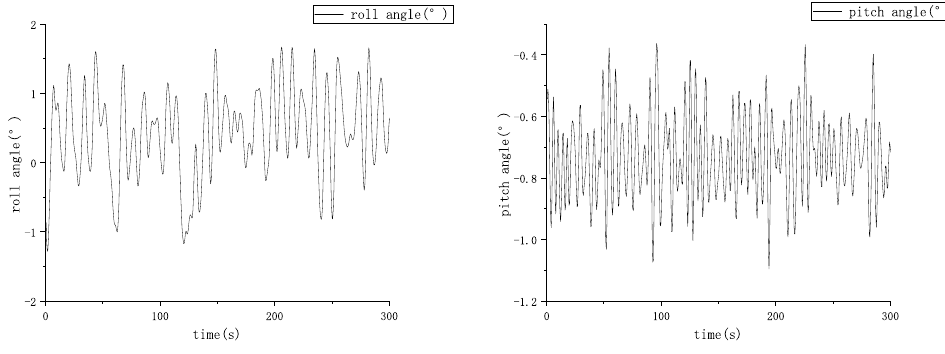
Figure 9. Dataset 4: The raw roll and pitch angle of the ship.